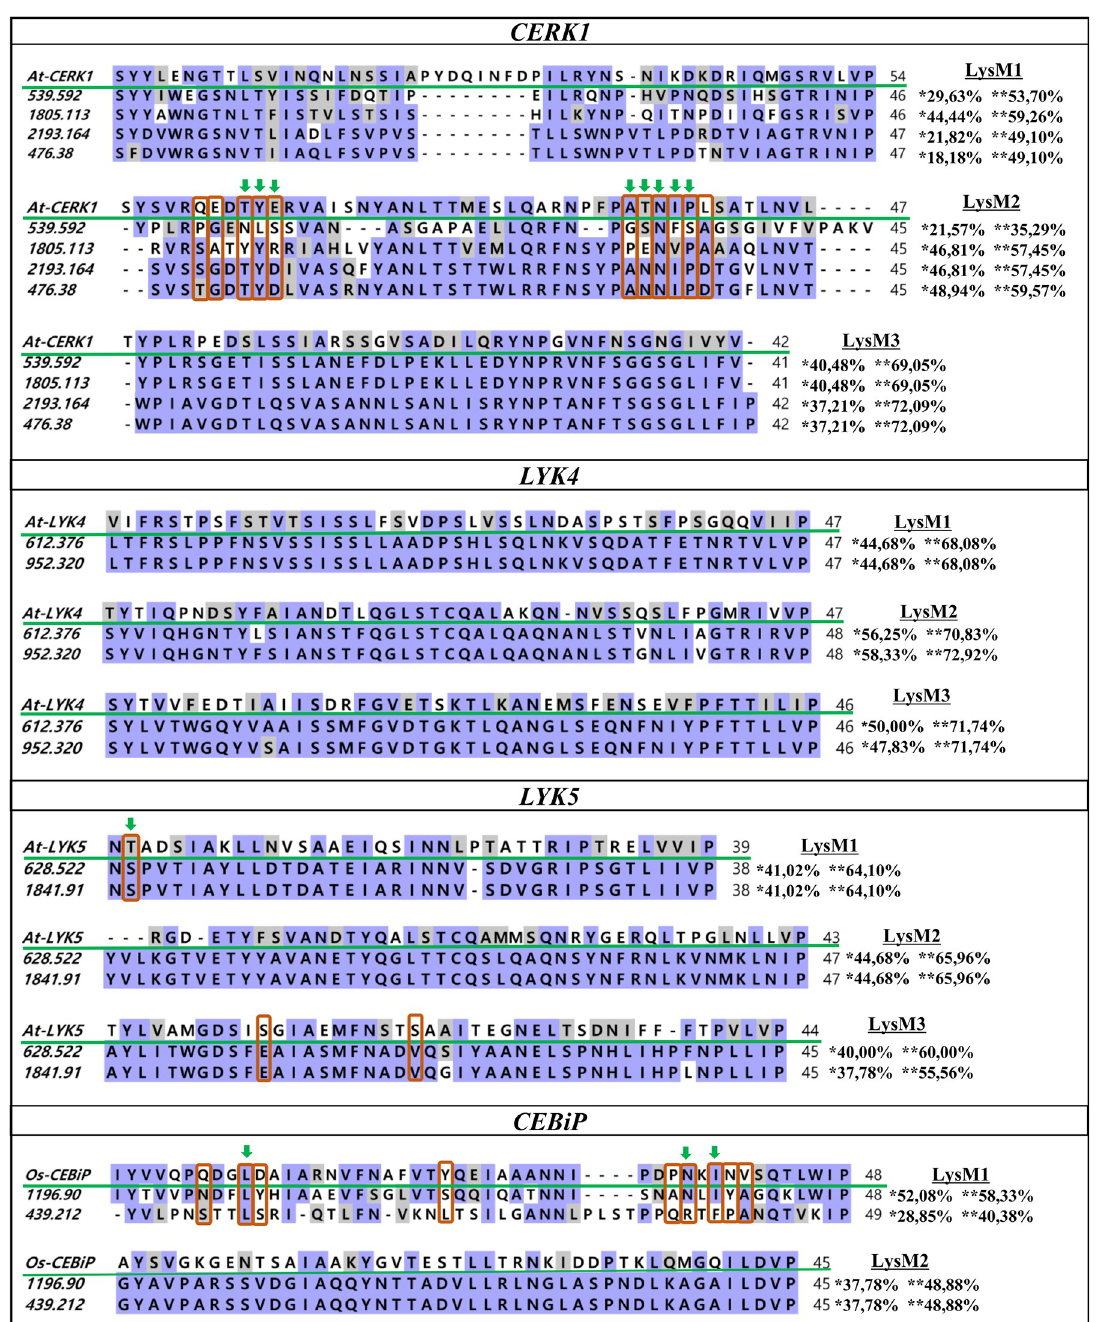
Fig 3. Alignment of the LysM motifs between reference sequences and candidate sequences in C . arabica . The LysM motif sequences were aligned using MAFFT and visualized by BioEdit. The numbers at the beginning of each sequence represents the scaffold (candidate sequence in C . arabica ). The green line highlights the reference sequence. The purple and gray shading represent identical and similar amino acids, respectively. The percentages of identity and similarity between candidate sequences and references are indicated by � and �� , respectively. In red are the critical residues that bind to chitin and the green arrows indicate residues identical or similar to these regions present in the candidate sequences in C . arabica . The numbers at the end of each sequence represent the size of the LysM motifs in number of amino